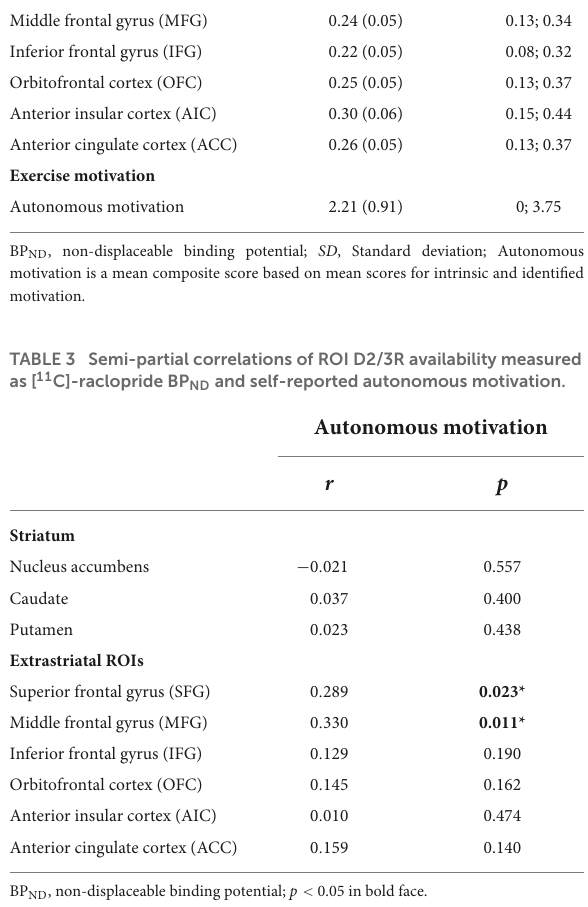
Table 3 controlling for ROI-volume, and Supplementary Table 4 controlling for ROI-volume, age, and sex). cardiorespiratory fitness level (VO 2 peak) and